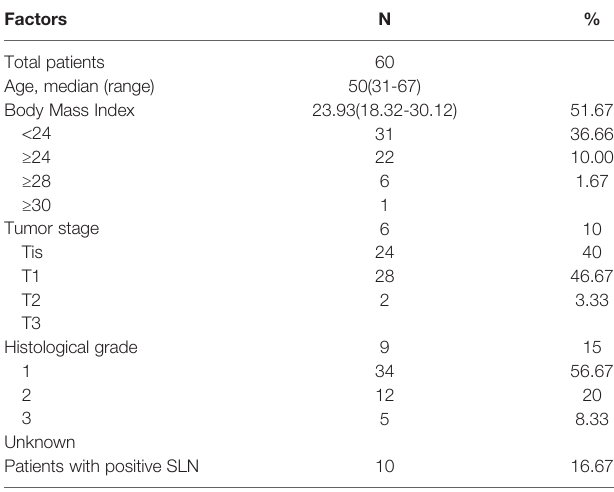
TABLE 1 | Tumor and patients characteristics.